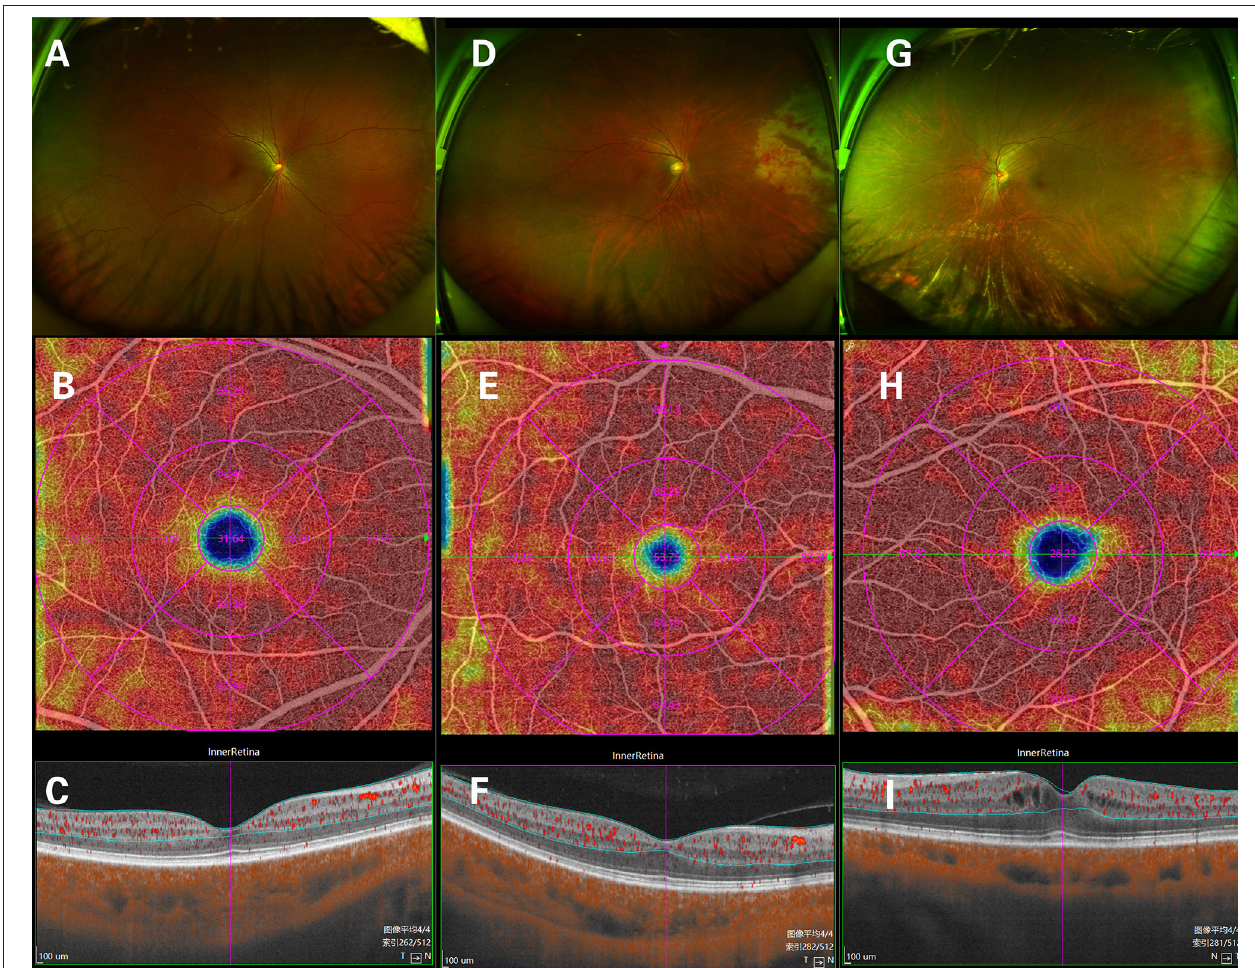
FIGURE 1 | The en face OCTA images of the inner retinal vessel density (VD) and corresponding B-scans (6 × 6mm scan pattern) in a normal eye (A–C) , an active CMVR eye (D–F), and an inactive CMVR eye (G-I) .